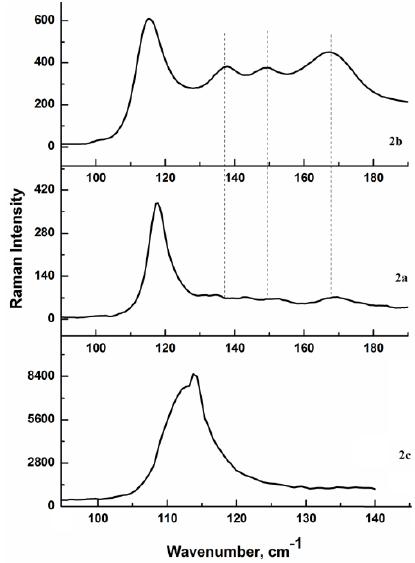
Figure 6. Experimental Raman spectra of crystals 2a–c in the low-frequency region.